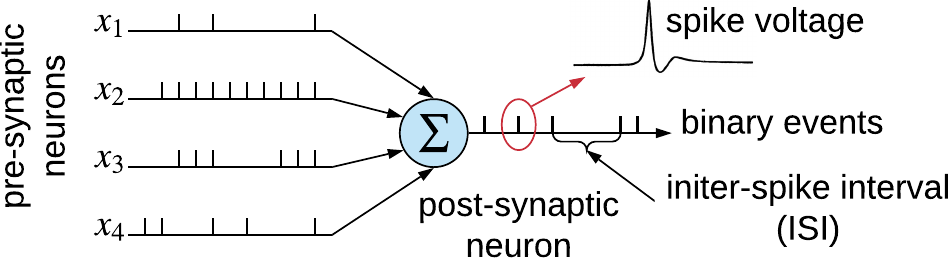
Figure 7. Integration of spike trains at the post-synaptic neuron from four pre-synaptic neurons in a spiking neural network (SNN). Each spike is a voltage waveform of ms time duration.